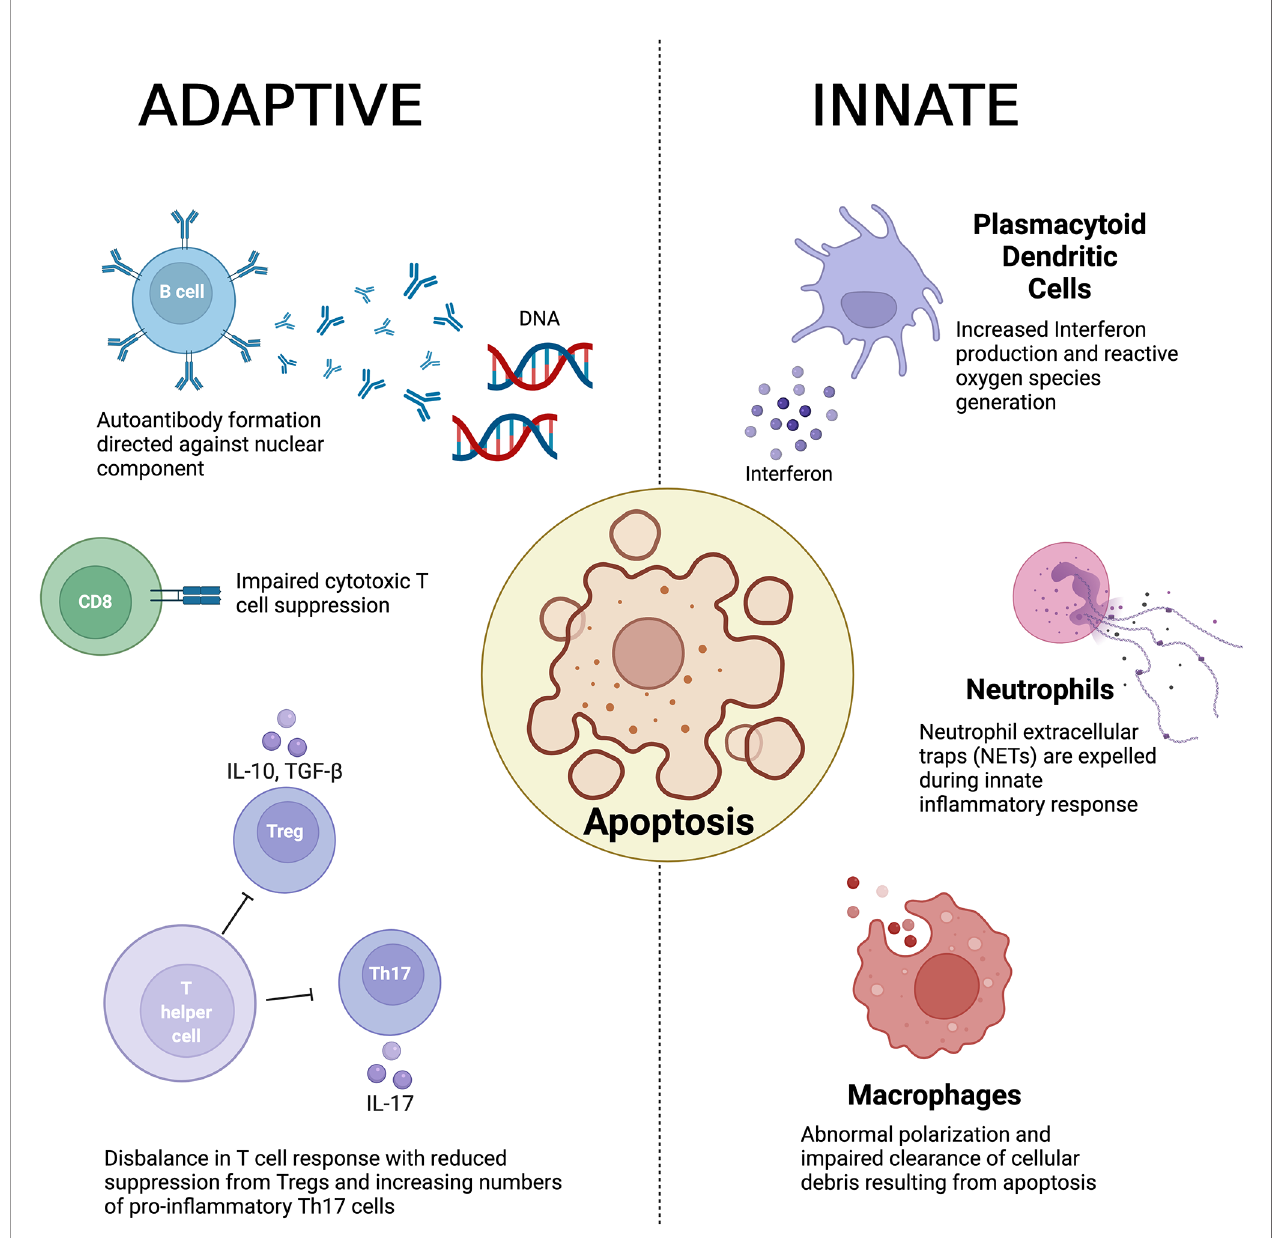
FIGURE 1 | A summary of the key immunological abnormalities described in the pathogenesis of systemic lupus